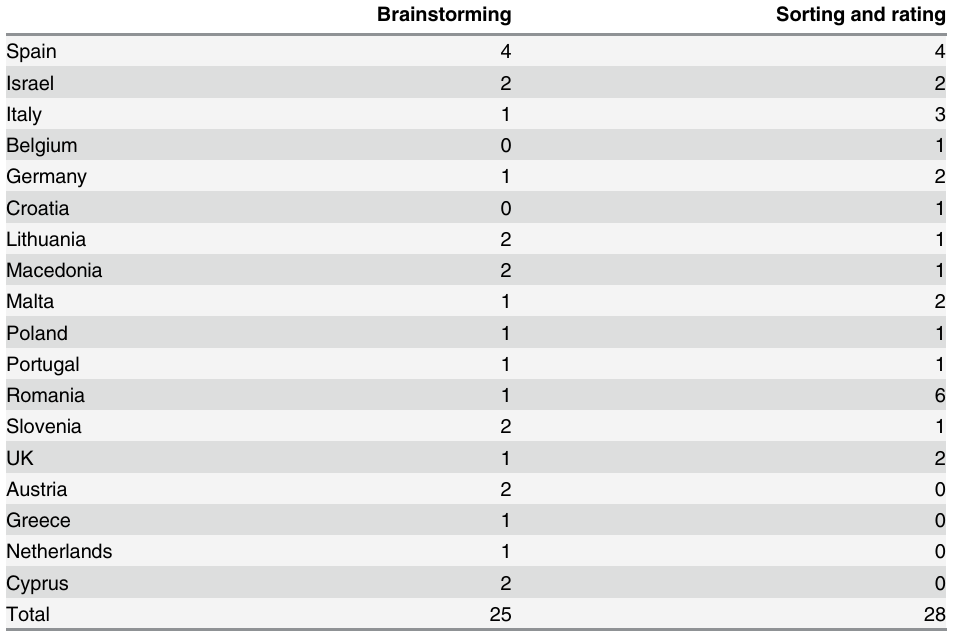
Countries represented among participants in the different phases of the concept mapping